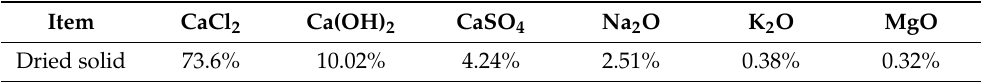
Table 5. Composition of the dried filtered solution from 3# filter